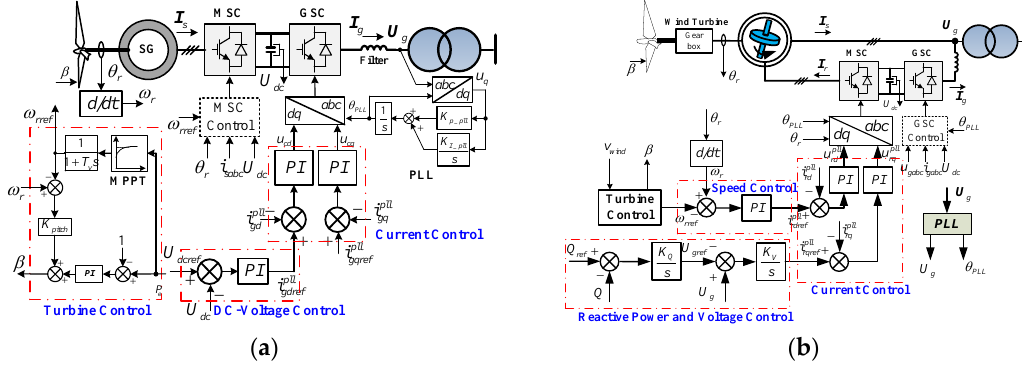
Figure 2. Basic control block diagram of WTs. ( a ) Type-4 WTs; ( b ) Type-3 WTs.